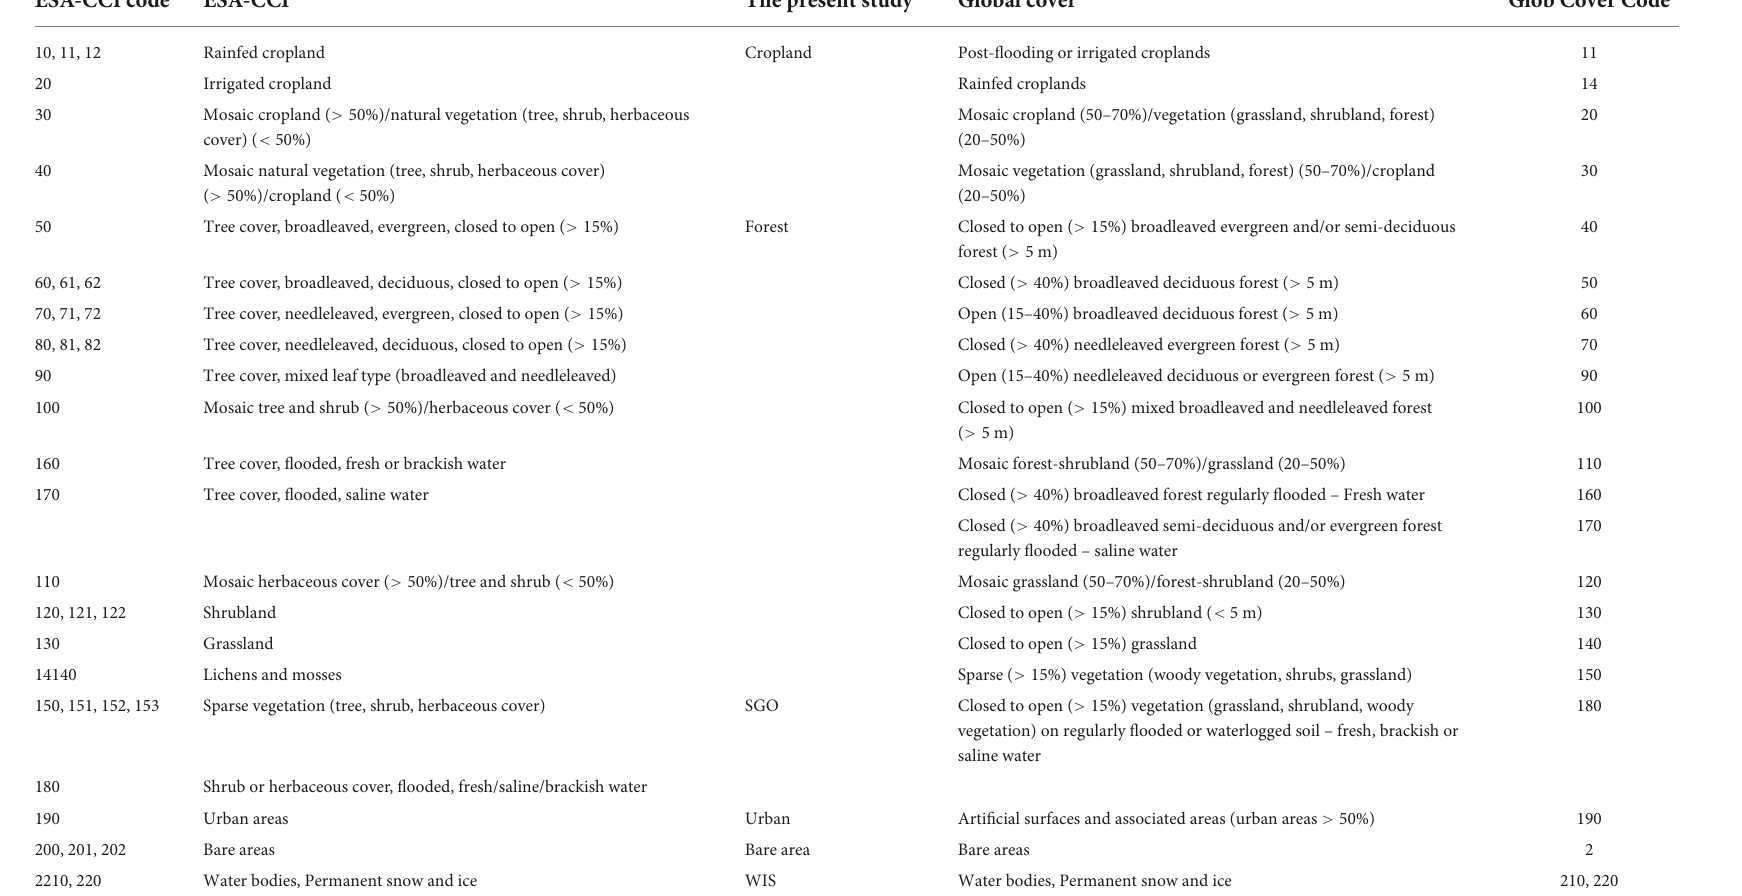
TABLE 1 The land-cover (LC) classes of the ESA, GlobCover, and the present